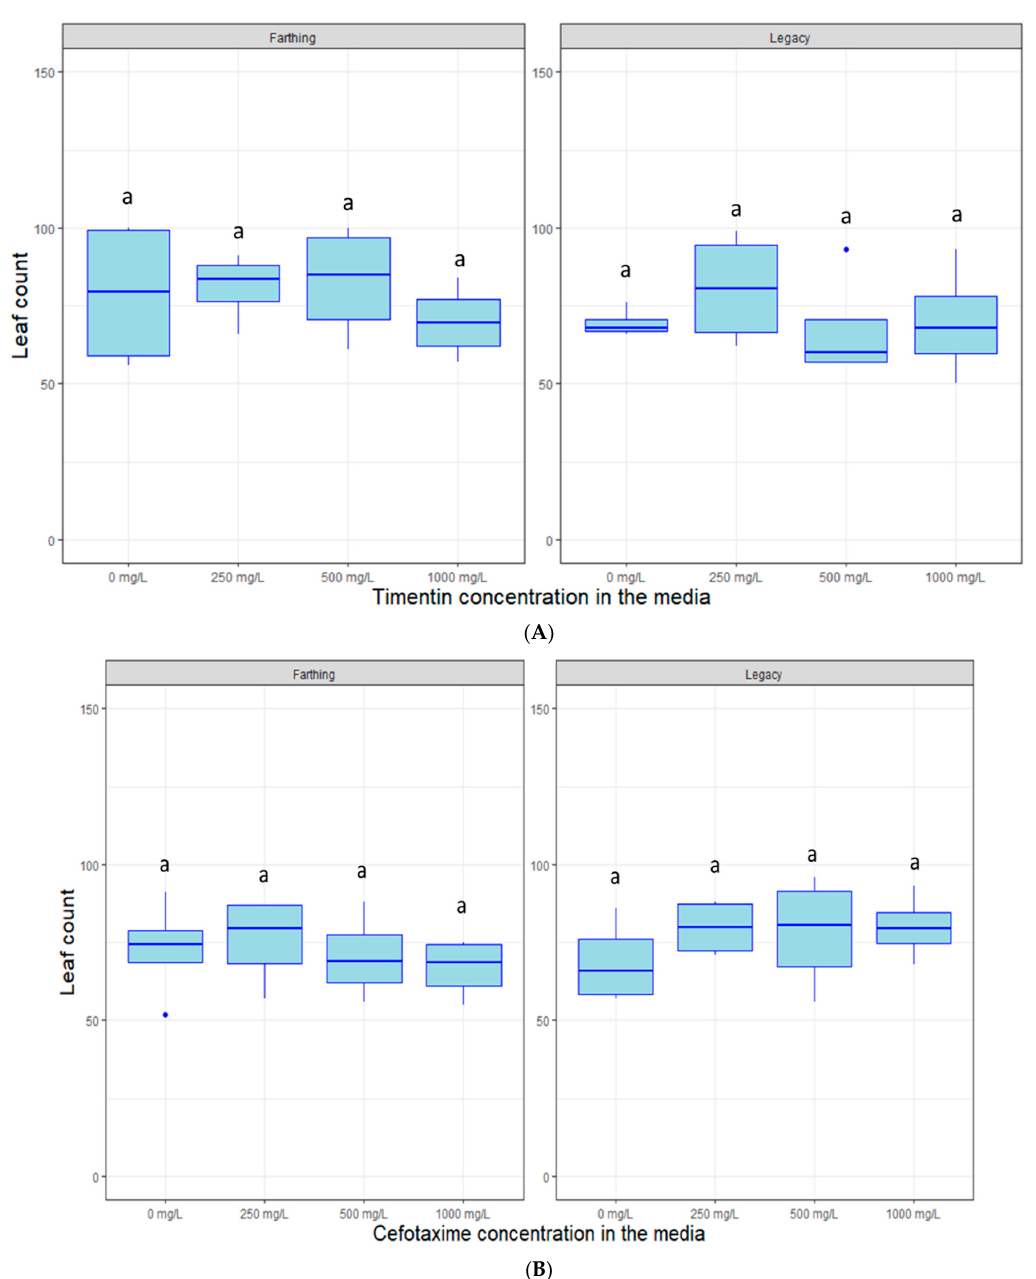
Figure 5. Box plot distribution of the effect of decontamination agents ( A ) timentin and ( B ) cefotaxime on leaf proliferation of blueberry genotypes “Farthing” (left panels) and “Legacy” (right panels) grown in tissue culture. Letters above boxplots indicate multiple comparison test. Treatments with the same letters are not statistically different at alpha = 0.05.